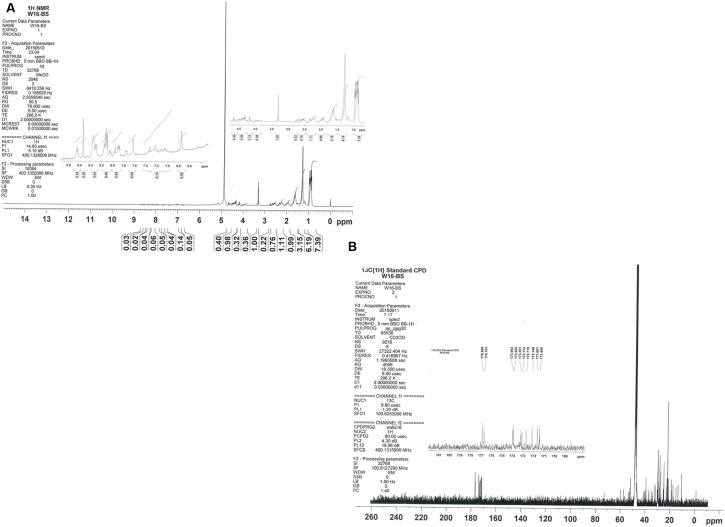
The NMR spectra for biosurfactant produced by of B. licheniformis W16 – 1H NMR (A) and 13C NMR (B).